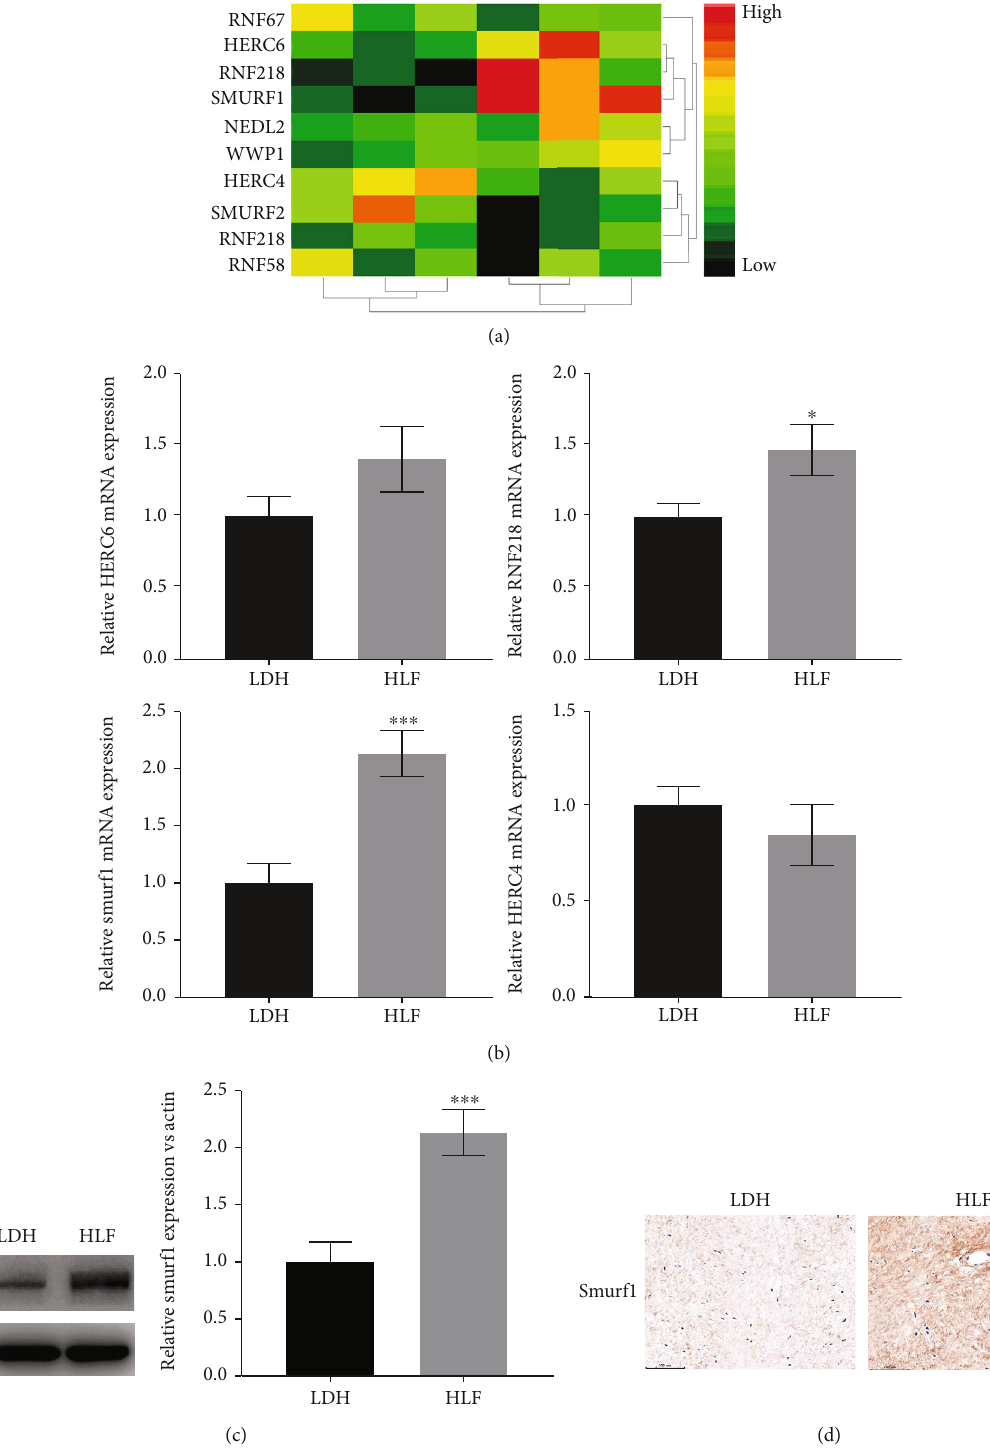
Figure 3: Smurf1 was upregulated in LF tissues from HLF patients. (a, b) The mRNA expression of the top ten E3 ligases was assessed by qRT-PCR array in the HLF and LDH group ( n = 27 ). ∗ p < 0 : 05 . ∗∗∗ p < 0 : 001 . (c) Western blotting and semiquanti fi cation for Smurf1 expression in the HLF and LDH groups ( n = 10 ). ∗∗∗ p < 0 : 001 . (d) Immunohistochemistry for Smurf1 expression in the HLF and LDH